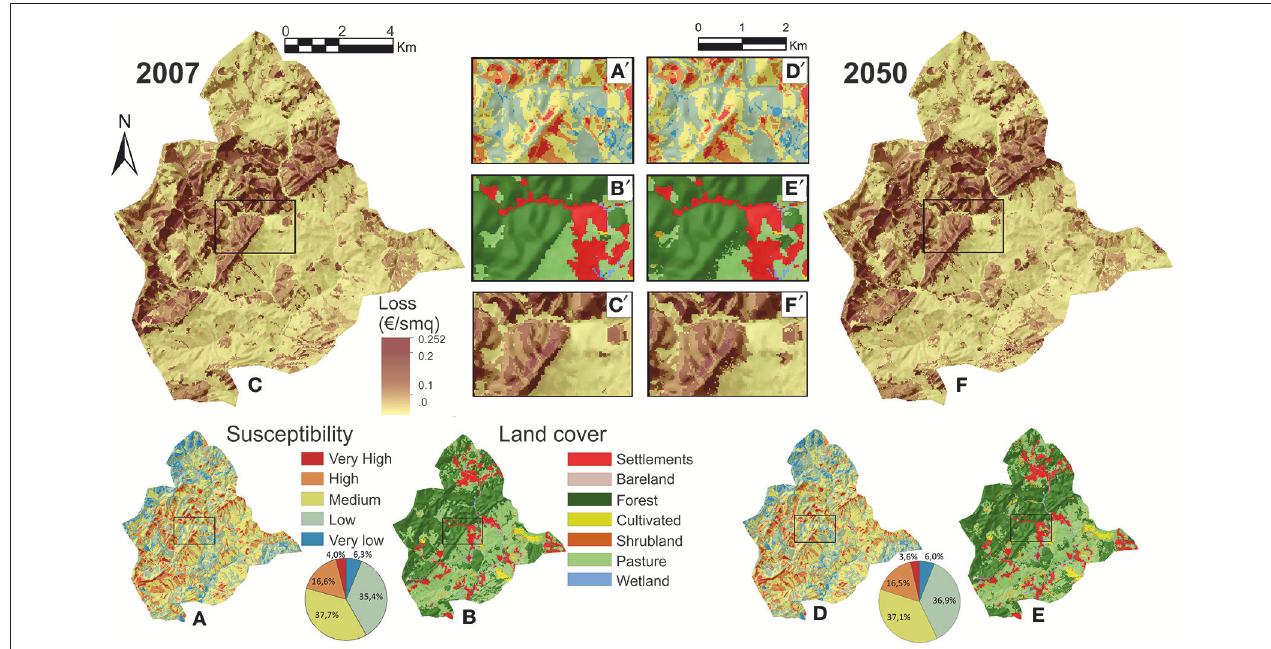
FIGURE 3 | B ˘ al ˘ aneasa catchment landslide susceptibility (A) , land cover (B) , and damage (C) maps for 2010 and 2050 (respectively, D–F ). In the zoomed squares (A ′ -C ′ for 2010, and D ′ -F ′ for 2050) some sectors of the related maps are highlighted. The pie charts represent the percentage area of the susceptibility classes related to the susceptibility maps (A,D)